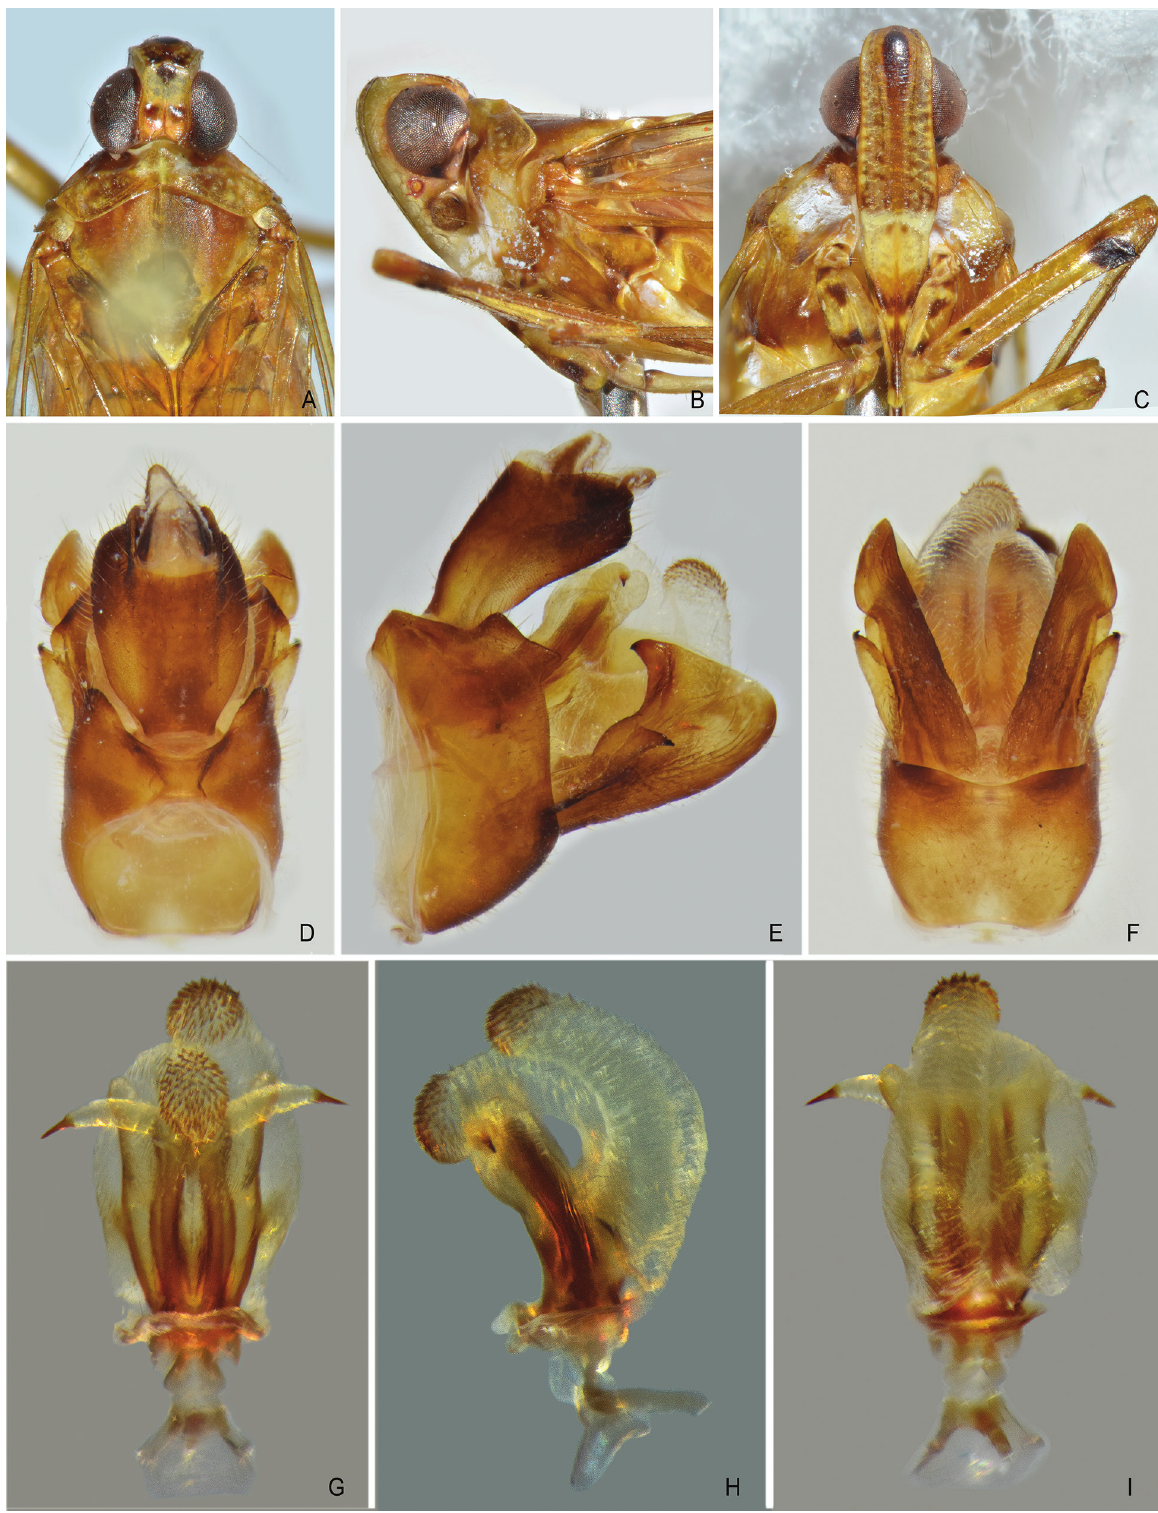
Figure 4. Orthopagus bartletti sp. n. ( A ) Head, pronotum and mesonotum, dorsal view. ( B ) Head and pronotum, lateral view. ( C ) Head and pronotum, ventral view. ( D ) Male segment X and pygofer, dorsal view. ( E ) Male pygofer, gonostyles, and segment X, lateral view. ( F ) Male pygofer and gonostyles, ventral view. ( G ) Aedeagus, dorsal view. ( H ) Aedeagus, lateral view. ( I ) Aedeagus, ventral view. CAS); 1 male, Mangrin, 9.vi.1904; 1 female, Mon Boi, 29.v.1904 (both